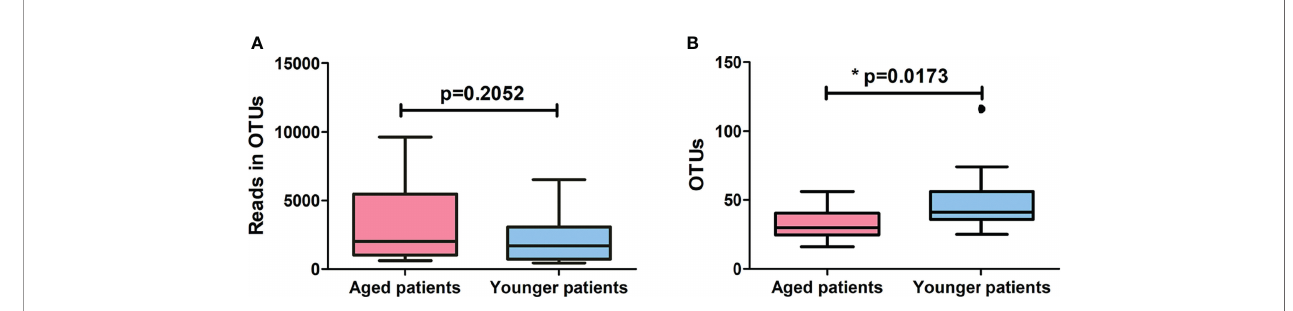
FIGURE 1 | Comparison of (A) reads in OTUs and (B) number of OTUs identi fi ed between aged and younger patients. *p < 0.05.